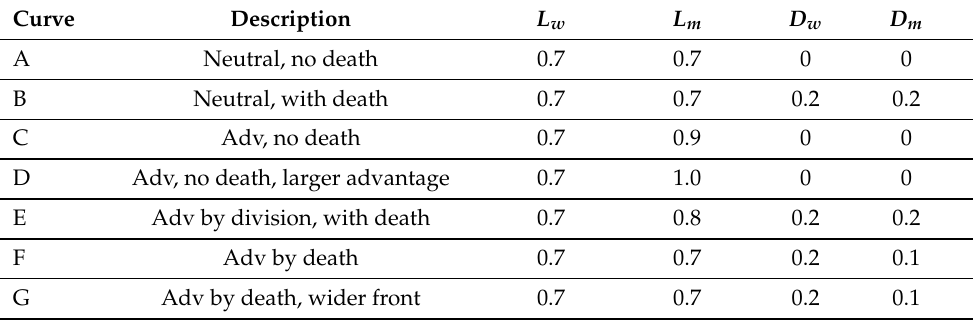
Table 3. Simulation parameters for Figure